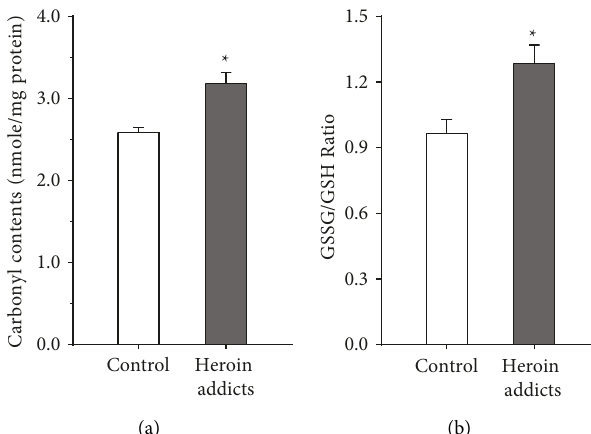
Figure 4: Comparative analysis of (a) protein carbonyl contents (nmol/mg protein) and (b) GSSG/GSH ratio in red cell lysates from study subjects: chronic heroin-addicted subjects and control subjects. Results are presented as mean ± SEM. ∗ indicates a significant comparative analysis with p � 0 . 001.